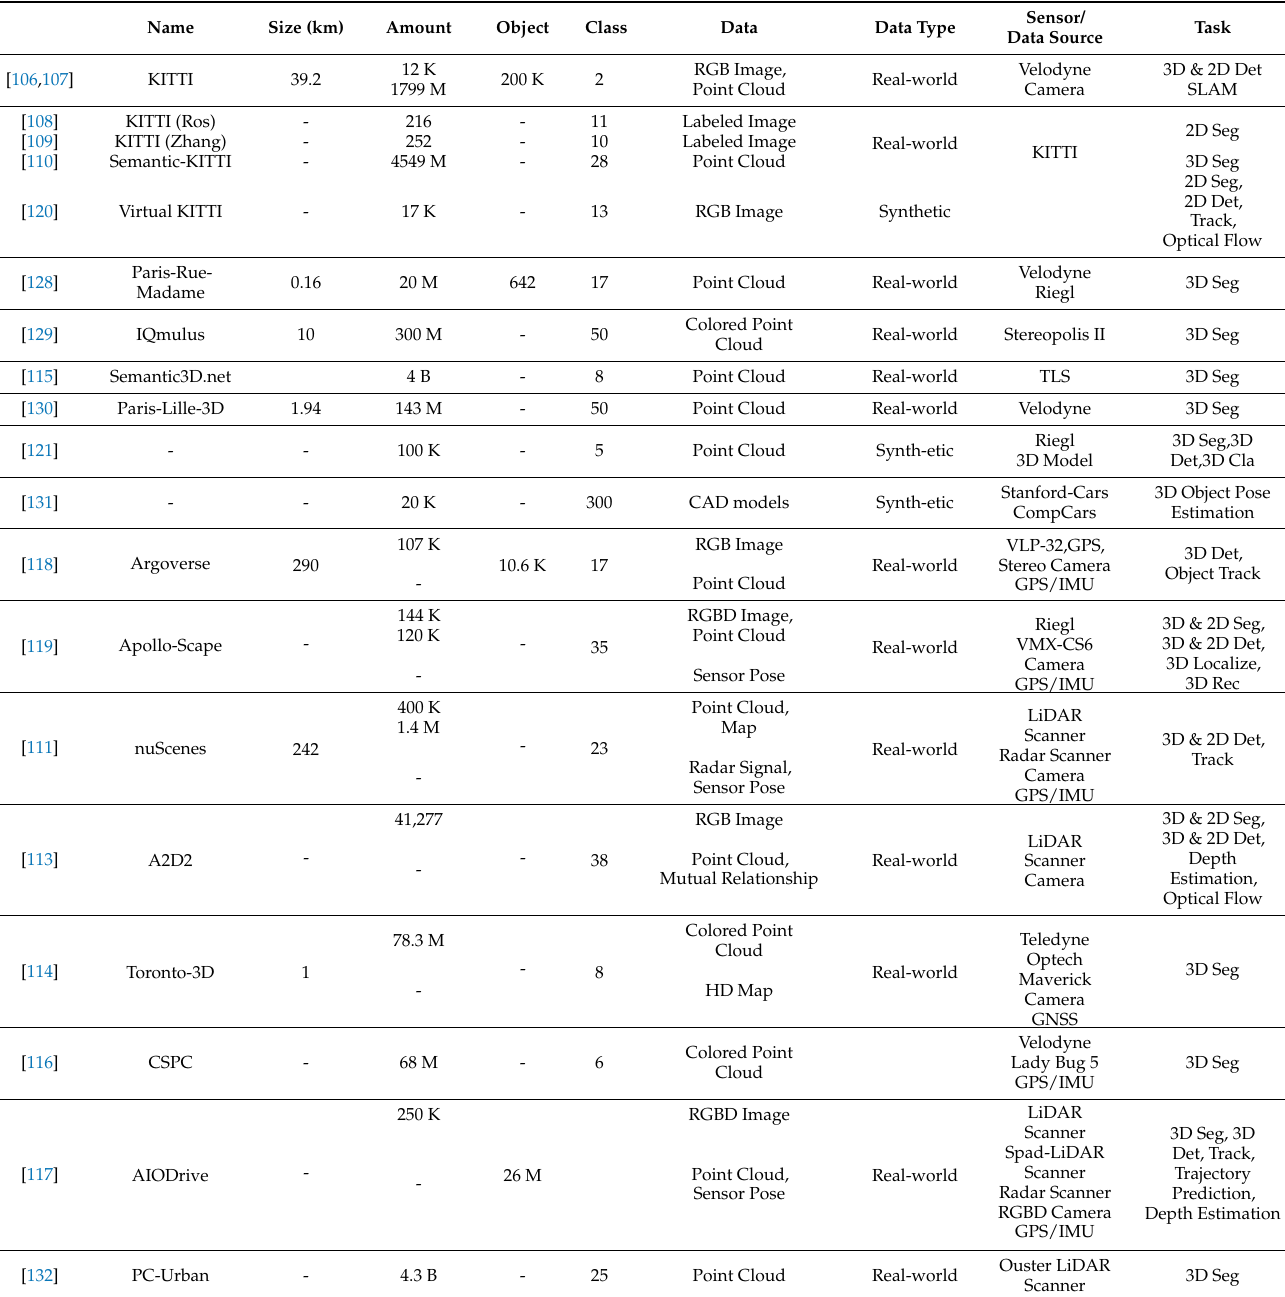
Table 4. Comparative summary of outdoor road-level datasets (Seg: segmentation; Rec: recognition; Cla: